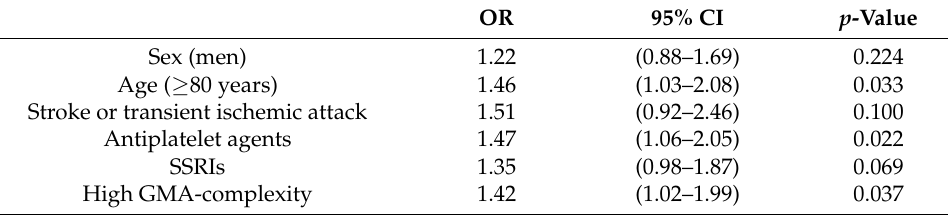
Table 5. ICH risk factors observed in the GMA-4 population according to multivariate-adjusted model. OR 95% CI p -Value Sex (men) 1.22